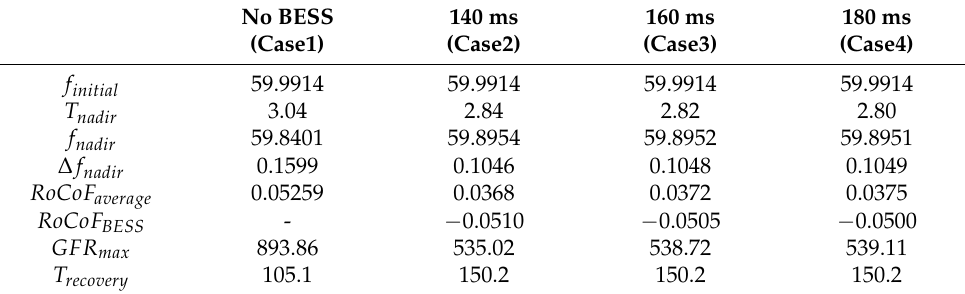
Table 3. Summary of simulation results from the several case studies.